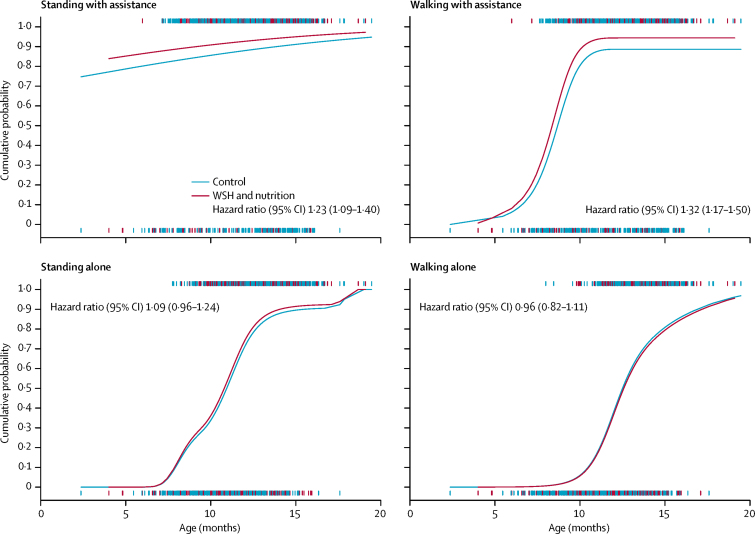
Cumulative probability of children who achieved four of the developmental milestones after 1 year of intervention in the WASH and nutrition group compared with the active control groupHash marks indicate the age of observed children who had achieved the milestone (1·0) or not achieved the milestone (0·0). WASH=water, sanitation, and handwashing.